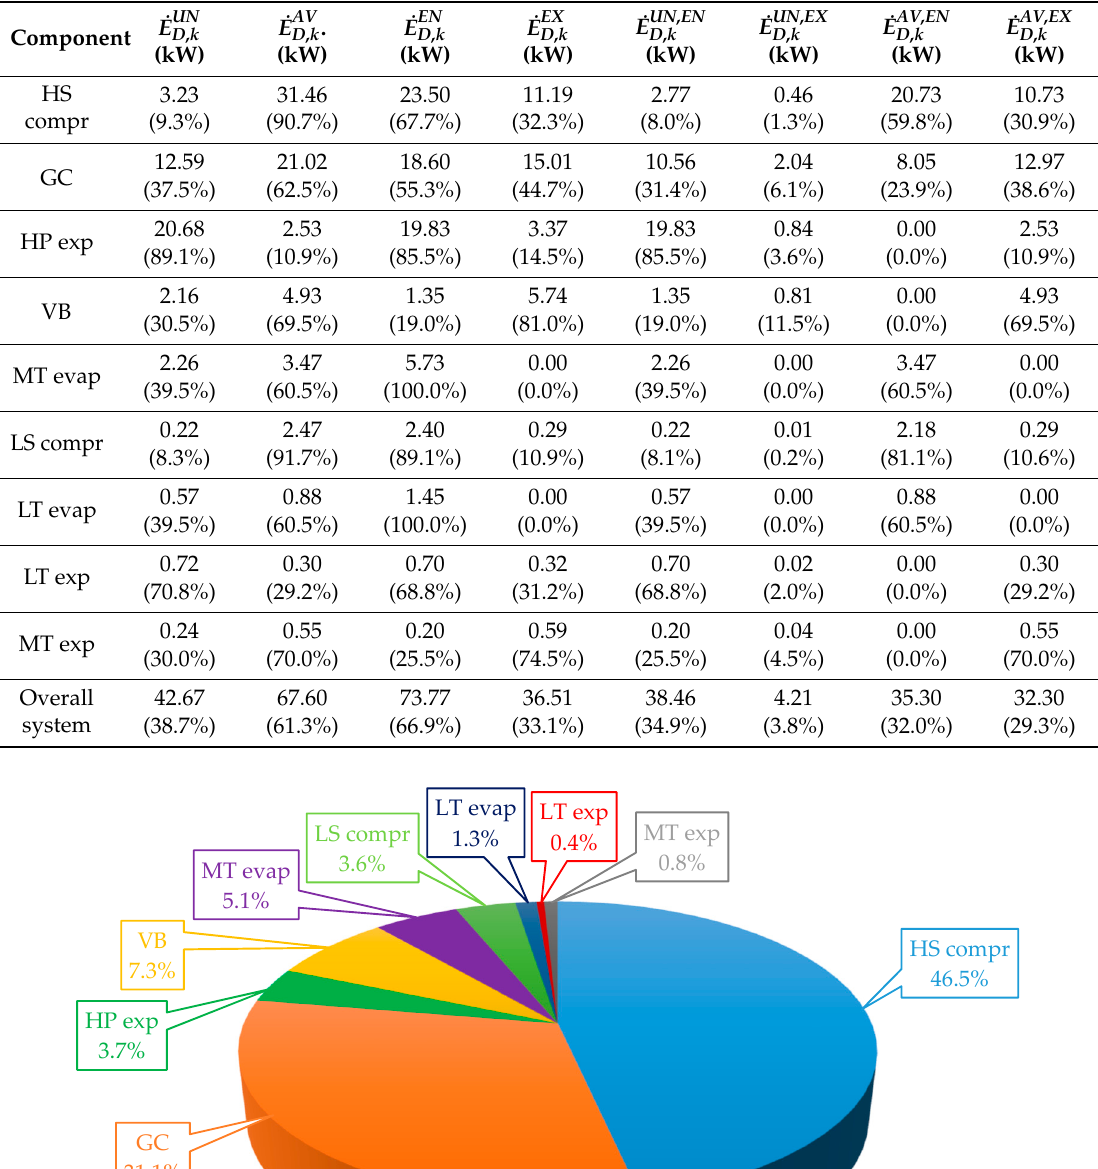
Table 8. Results related to the advanced exergy analysis for CB at the outdoor temperature of 40 °C.